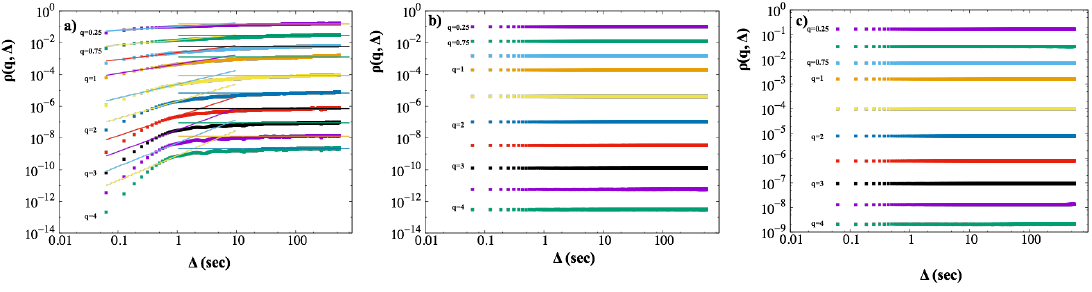
Figure 5. Generalized moments of ( a ) temperature and ( b ) conductivity as functions of the lag time, ∆ , for different moments q ; ( c ) the same as ( a ) for the temperature shuffled time